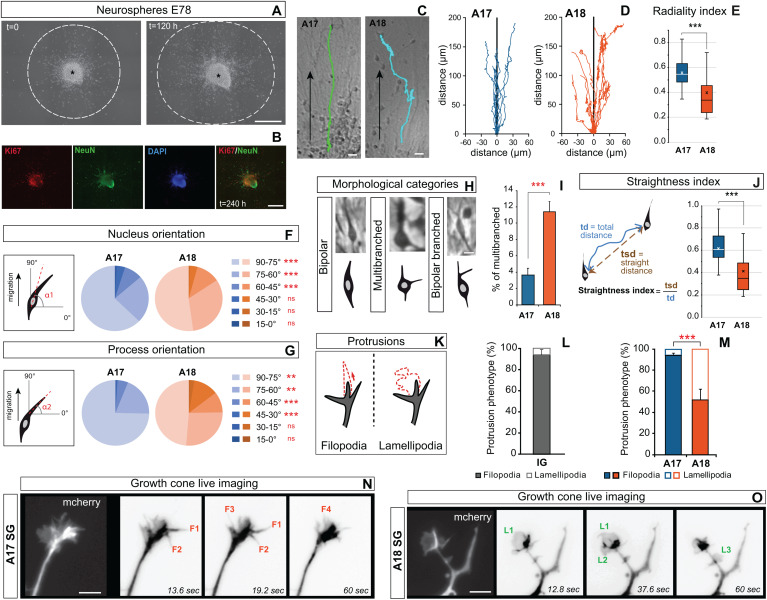
(A) Photographs of A18 SG derived neurospheres 4 days after plating, (t = 0) (left panel), and 10 days after plating (t = 120 h) (right panel) showing neuronal migration extent (dotted line) out of the neurosphere. (B) At the end of the live recording, neurons are identified using NeuN and Ki67 immunostaining. NeuN+/Ki67– cells, are considered post-mitotic neurons. (C) Typical trajectory of A17 and A18 SG neurons migrating out of the neurosphere. (D) Typical trajectories of migrating SG neurons reconstructed from time lapse observations. (E) Area 17 and Area18 SG neuron trajectories radiality index. (F,G) Nucleus (F) and process (G) change in orientation during A17 and A18 SG neuronal migration out of neurospheres. (H) Morphology of SG neurons migrating out of the A17 and A18 neurospheres along their trajectory. Three main categories were identified: bipolar, with two processes located at the opposite poles of the soma; multibranched: with multiple processes growing out of the cell body; bipolar branched: with a branched leading process. (I) Percentage of time spent as multibranched for A17 and A18 SG neurons during their migrating trajectory (J) The straightness index is computed over the entire trajectory and corresponds to the ratio of the straight distance between the origin and the endpoint of migration (tsd) divided by the total distance covered by the neuron (td). (J) Area 17 and Area18 SG neuron trajectories straightness index. Black and white crosses indicate the mean. (K) Two types of growing membrane protrusions are observed on the growth cone and/or along the leading process of migrating SP neurons: filopodia (spike-like long protrusions, Left) or lamellipodia (broader sheet-like protrusions, Right). (L) Protrusions phenotype frequencies in occipital IG neurons. (M) Frequency of filopodia and lamellipodia observed on A17 and A18 SG neurons. (N) High magnification protrusions observed on a typical growth cone of an A17 SG SP neuron leading process labeled with mCherry. Imaging took place over 1 min. Four growing protrusions, classified as filopodia (F1 to F4), are highlighted. (O) High magnification of a typical growth cone of A18 SG SP neurons labeled with mCherry Three growing protrusions, classified as Lamellipodia (L1 to L3) are highlighted. (E,I,J,M) Two-tailed and unequal variance Student test, p values < 0.005*⁣**. (F,G) GLM test, p values < 0.01∗∗, < 0.001*⁣**. Scale bars: A,B: 500 μm, C: 20 μm, H = 10 μm, N,O = 5 μm.